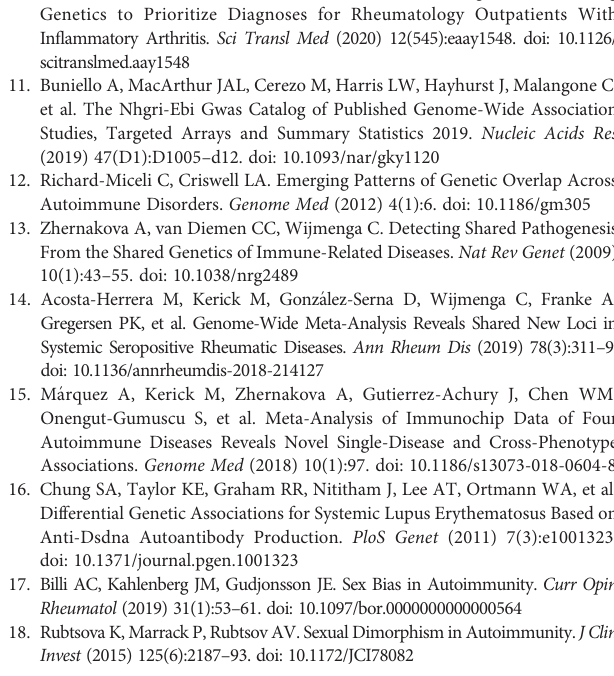
disease diagnosis ( Table 2 ). Systematic integration of PRS with routine clinical biomarkers is an important next step for PRS to become a useful clinical screening tool.